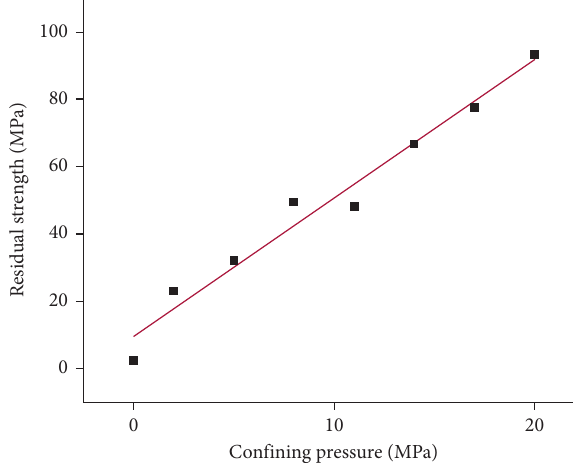
Figure 4: Relationship between triaxial strength and residual strength and confining pressure of coal samples.